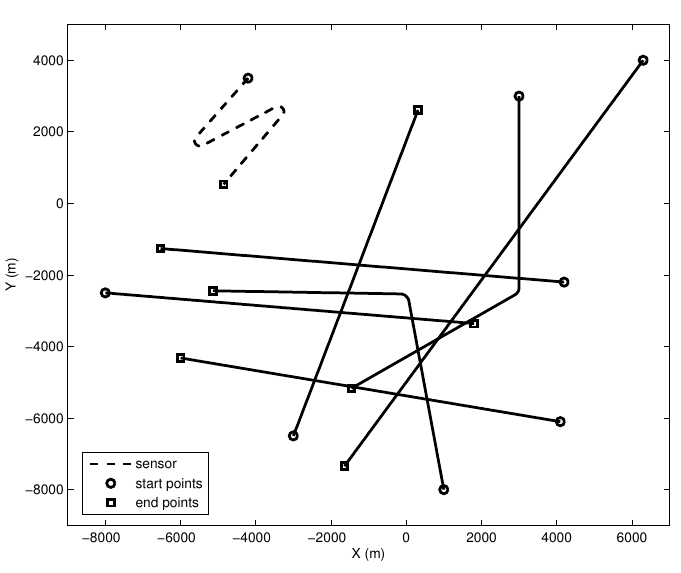
Figure 4. The geometry of the sensor and targets.